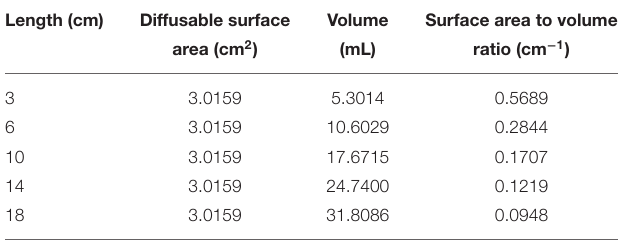
TABLE 2 | Dimensions of the subcutaneously implanted tissue